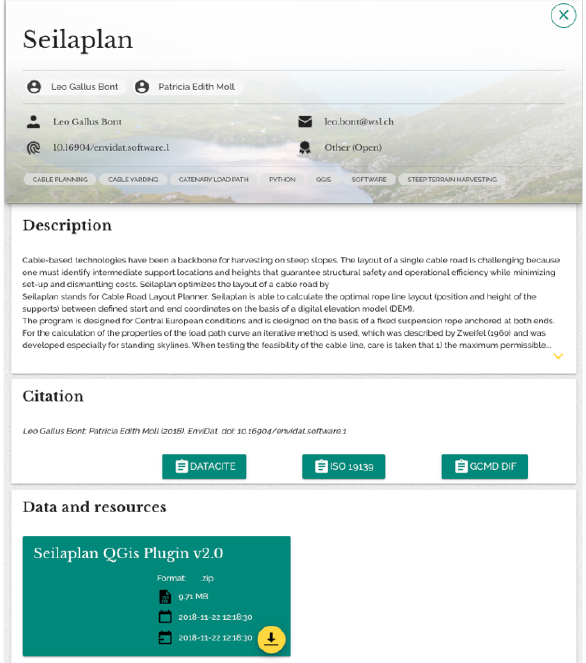
Figure 3. Example of a published FOSS4G in